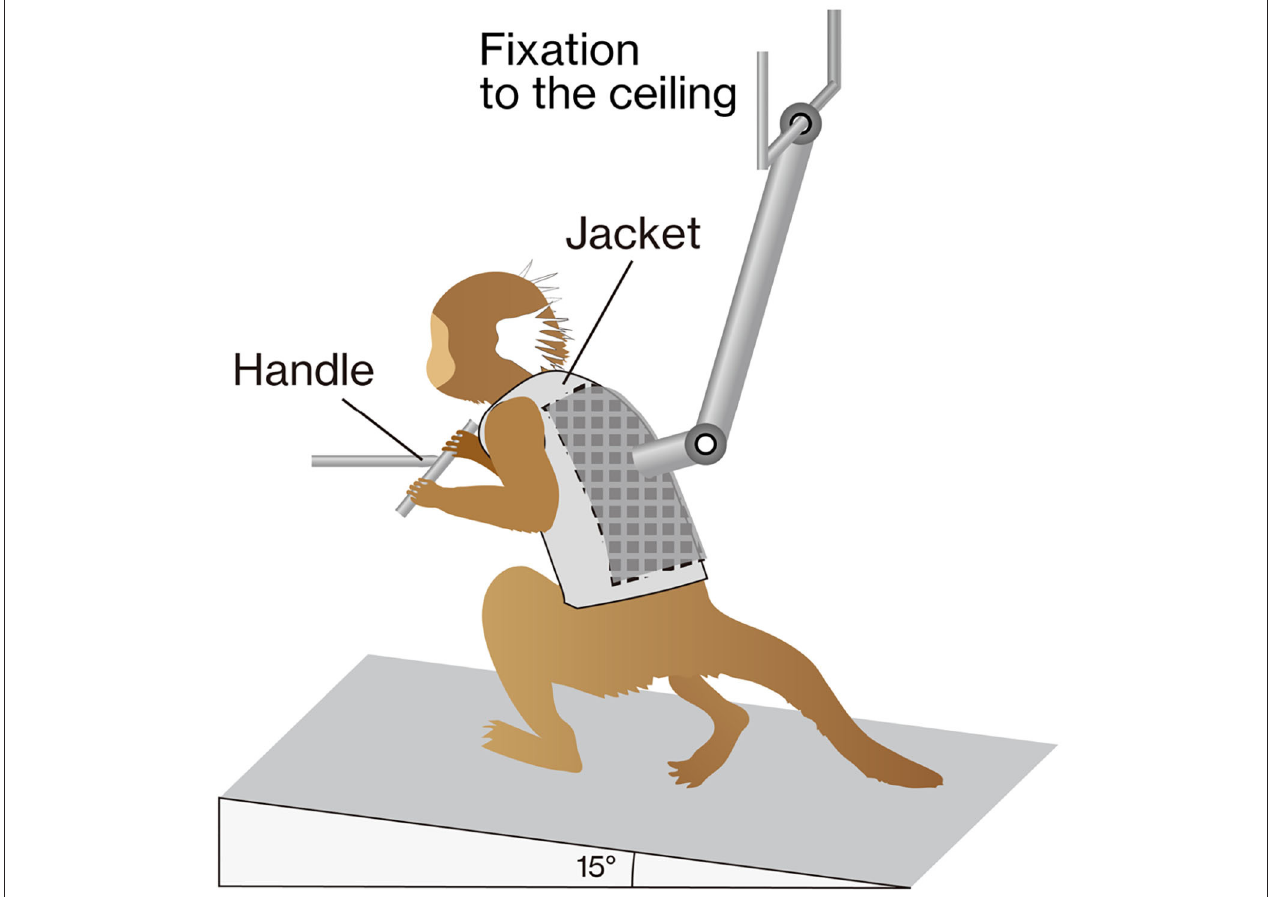
FIGURE 1 | The training apparatus. The marmoset was placed on a treadmill (inclined by 15 ◦ ) with a custom-made jacket attached to the ceiling for weight support. The gripping handle was positioned in front of the animal. During training, marmosets were rewarded to keep them stable.